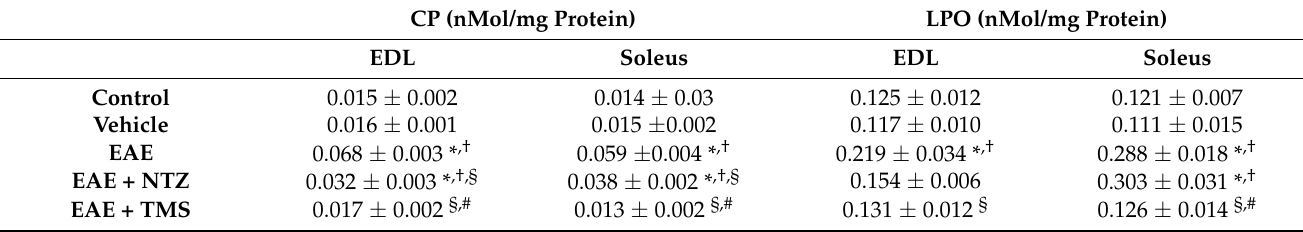
Table 2. Values of carbonylated proteins (CP) and lipid peroxidation products (LPO) in skeletal